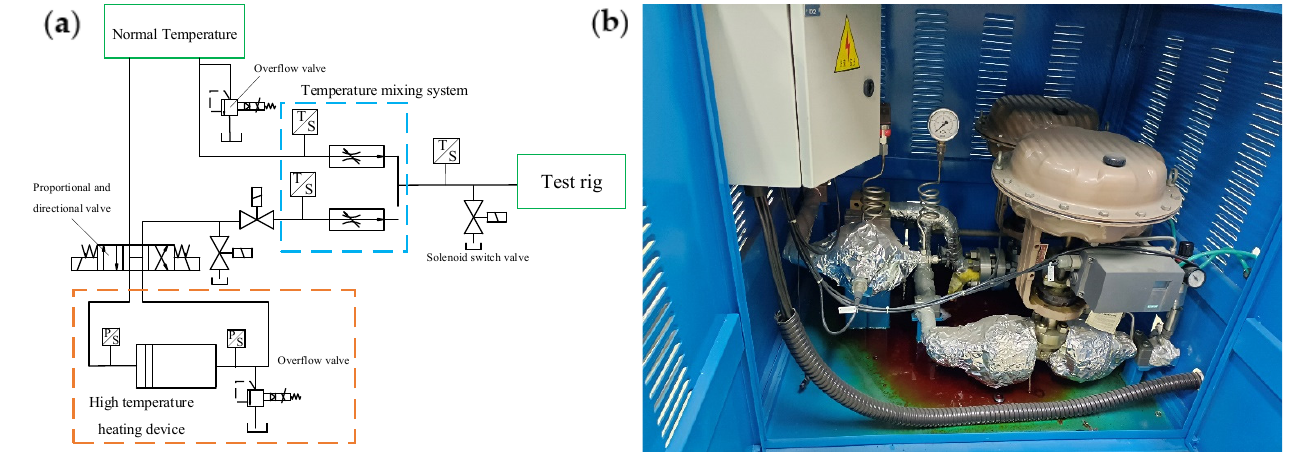
Figure 21. ( a ) The principle of hydraulic oil temperature control system; ( b ) The high-temperature characteristic test rig.